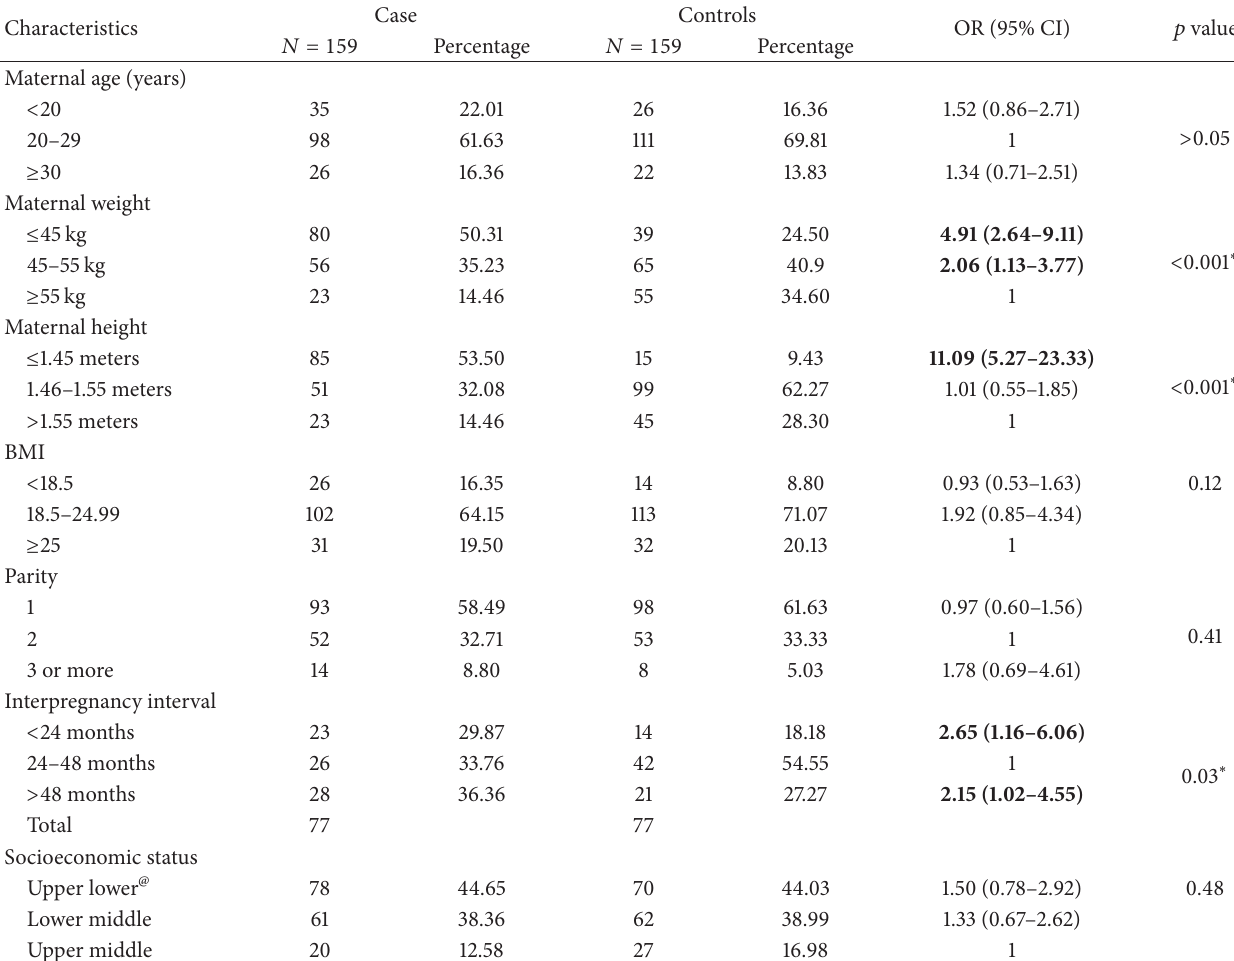
Table 2: Maternal risk factors associated with low birth weight